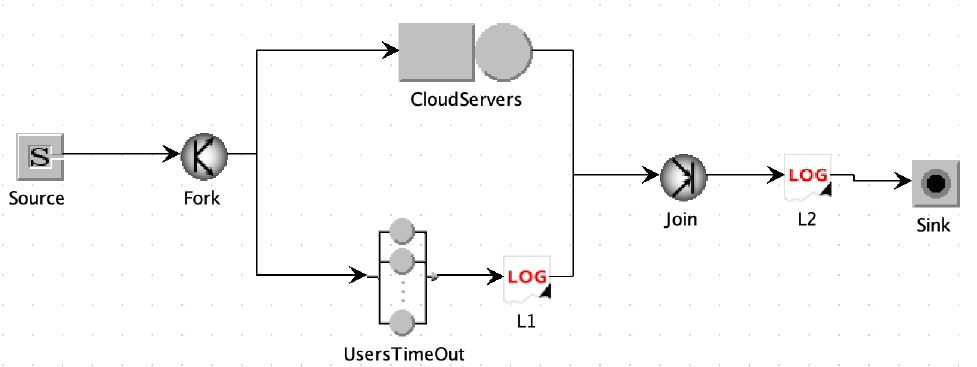
Figure 2. Model of a cloud application with user’s timeout.